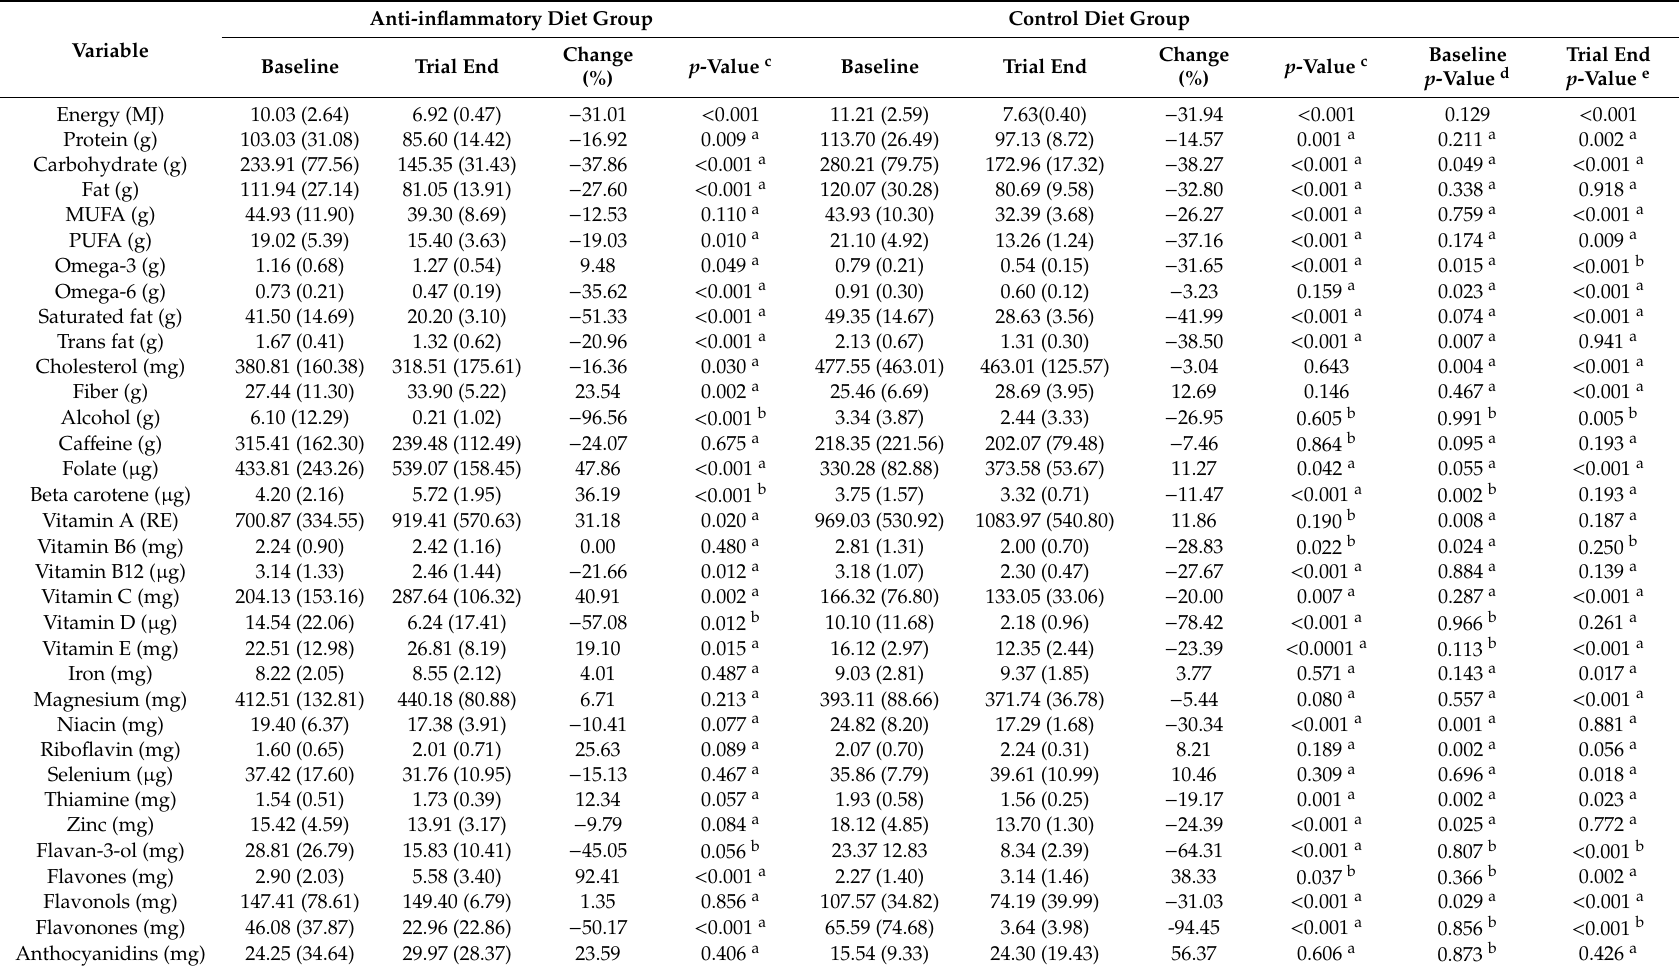
Table 2. The changes in the dietary parameters of the DII ®